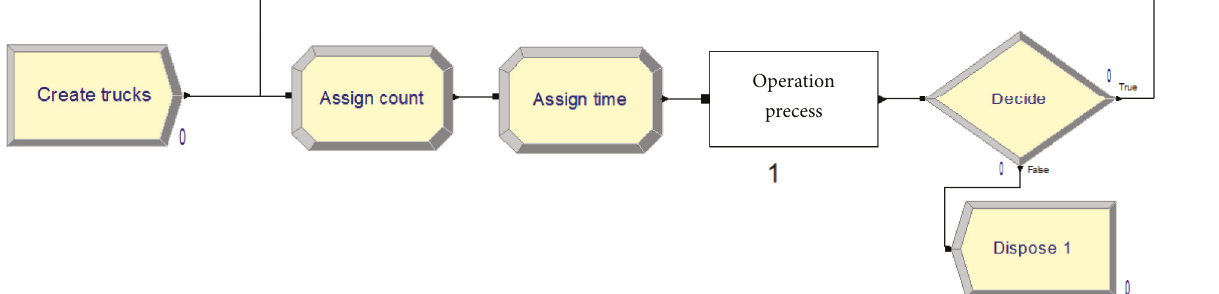
Figure 8: The truck transport